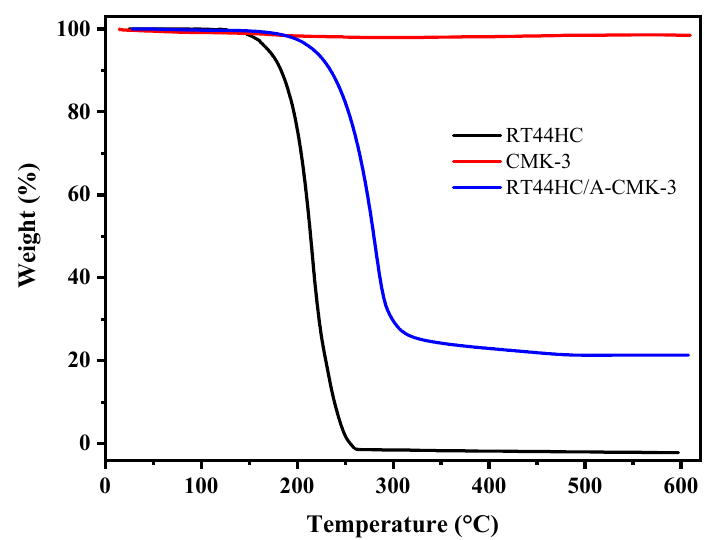
Figure 9. Thermal stability of A-CMK-3 based PCM.